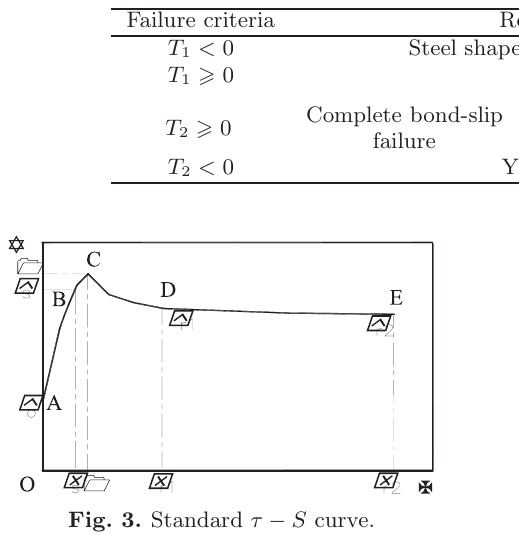
Table 1. Failure criteria of bond-slip.